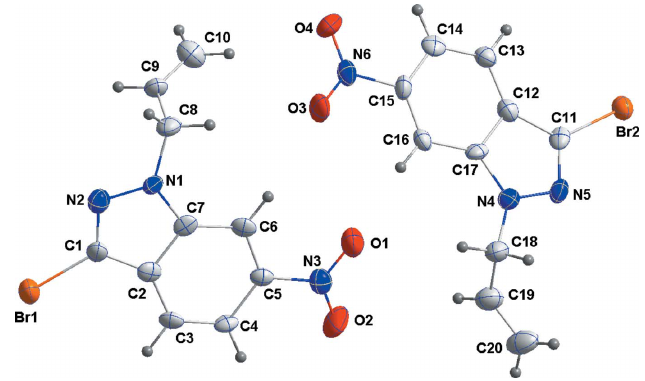
Figure 1 The asymmetric unit showing 50% probability